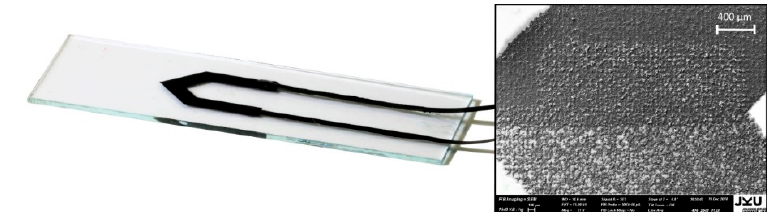
Figure 2. Left : Example thermocouple made from two different carbon-black inks on glass substrate with connection strips. Right : An SEM image of the area at which the printed features overlap.